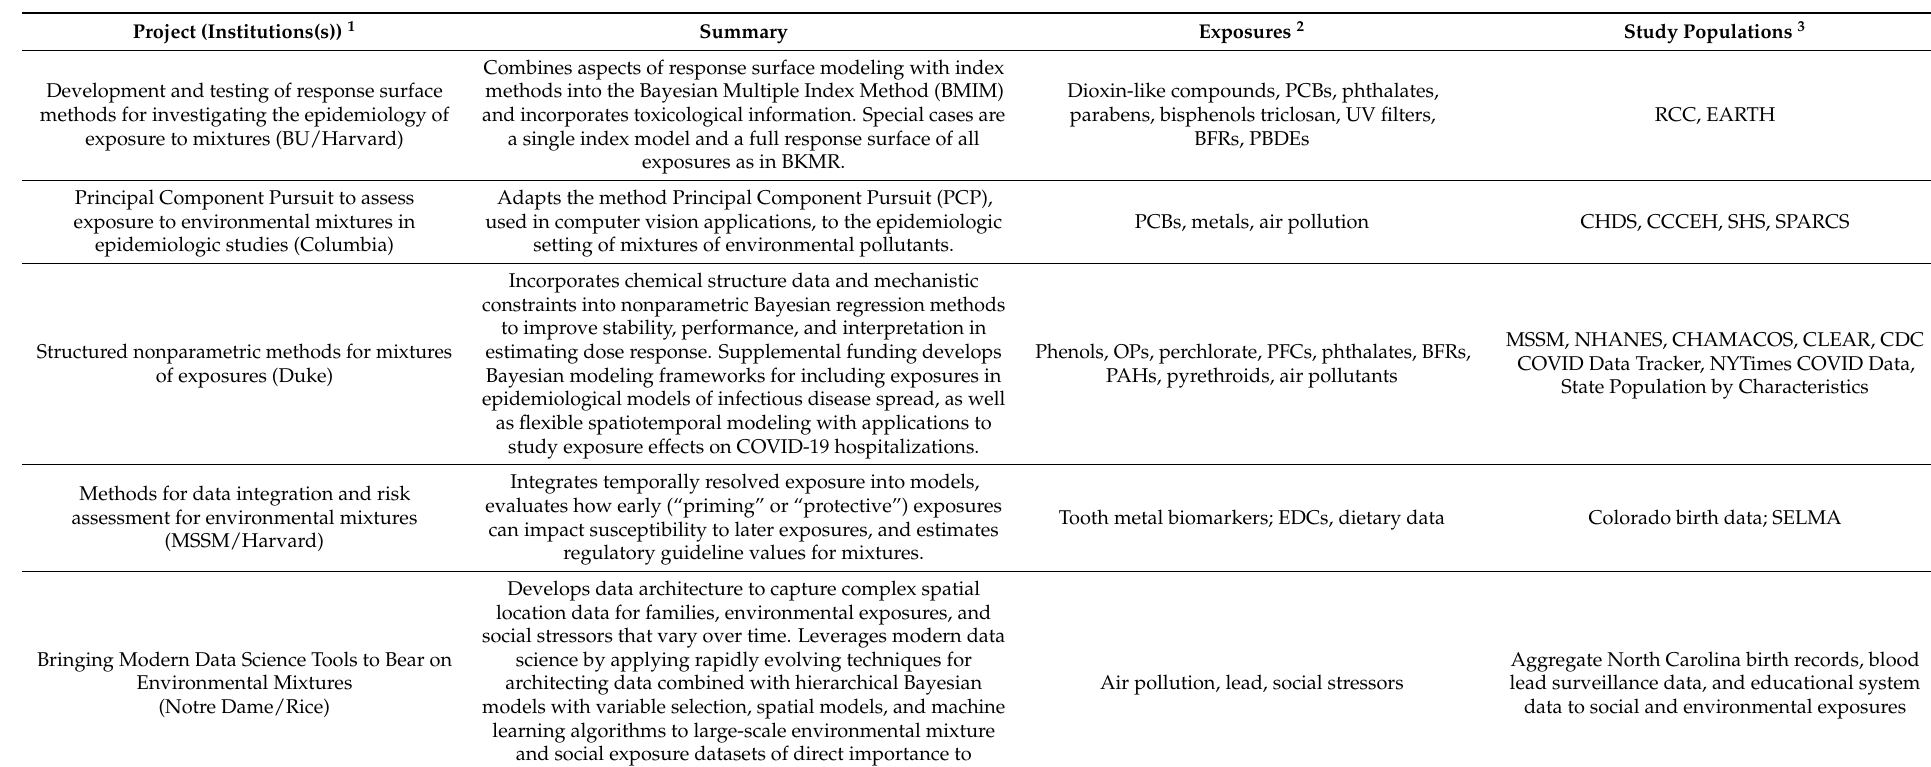
Table 1. Summary of PRIME